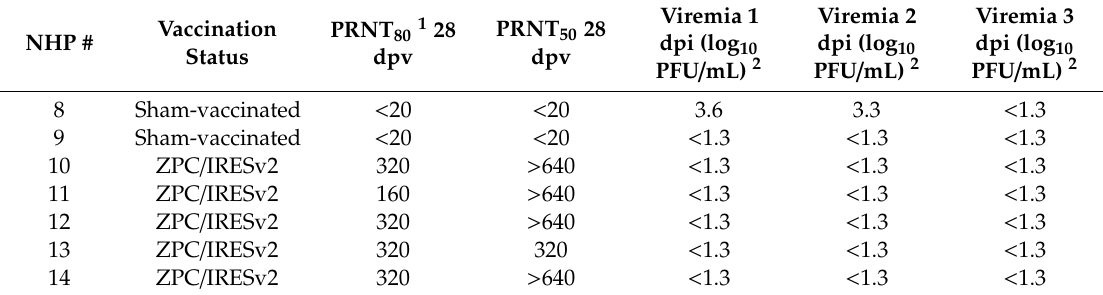
Table 4. ZPC / IRESv2 vaccination and protection in cynomolgus